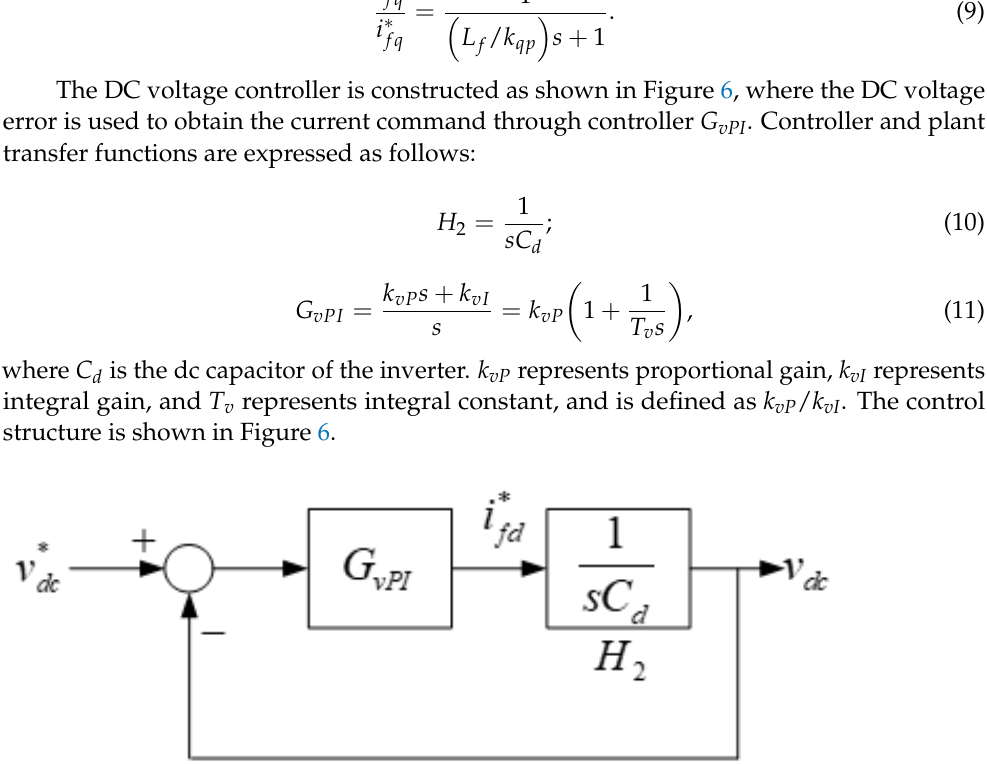
Figure 6. Schematic architecture of the DC voltage controller. Based on Figure 6, the close-loop transfer function of the DC voltage controller can be expressed as shown in Equation (12). As a result, the complete inverter controller can be obtained as shown in Figure 7.